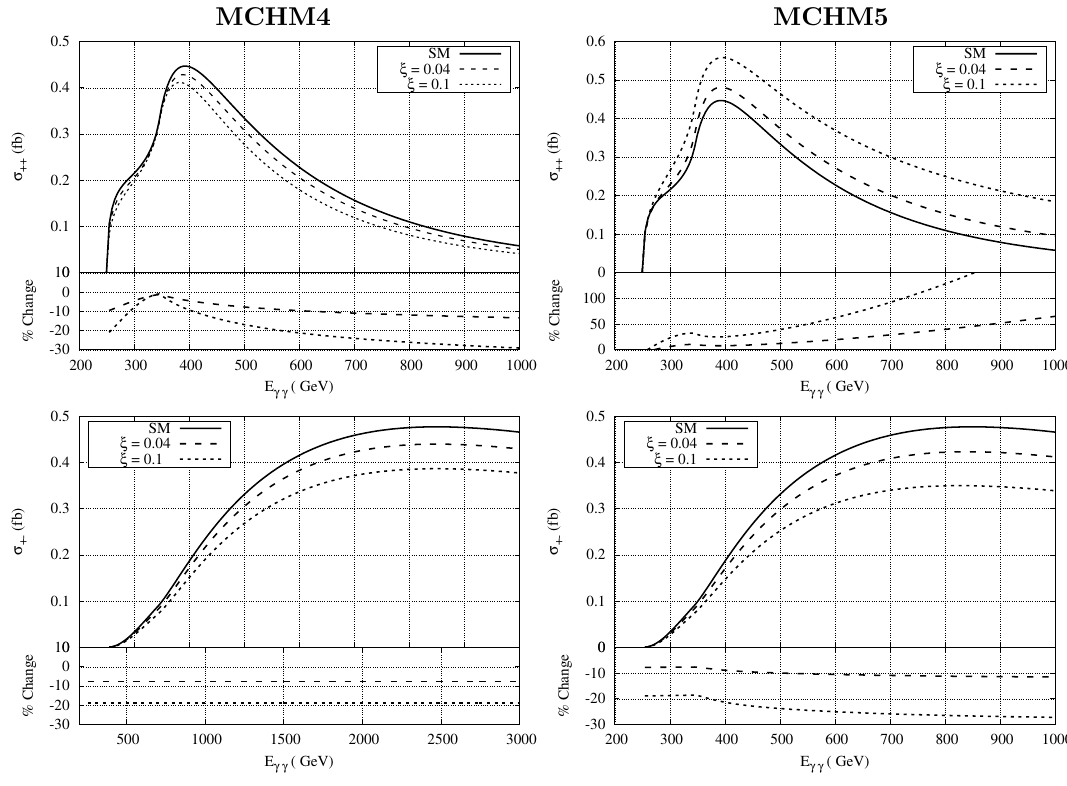
Figure 3 . γγ → hh helicity cross-section for same photon helicities (top panels) and opposite photon helicities (bottom panels) in the MCHM4 (left-column) and MCHM5 (right-column) bench-